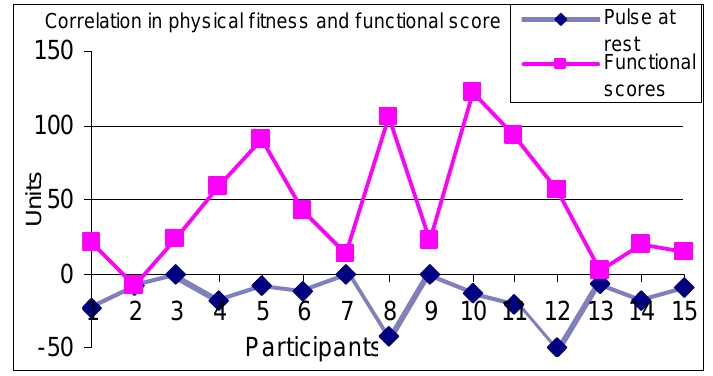
FIGURE 4 . A correlation between change in pulse at rest and change in functional scores. The figure represents the correlation between the change in individual functional score vs. the change in individual heart rate at rest for each participant between tests O 2 (at the beginning of the intervention program) and O 3 (at the end of the intervention